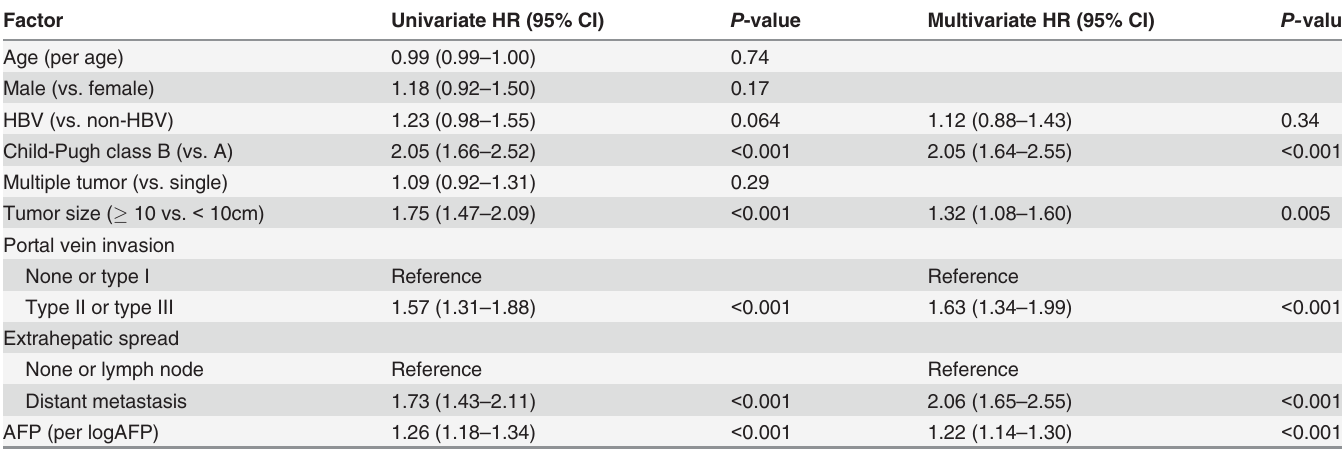
Table 2. Factors associated with survival.